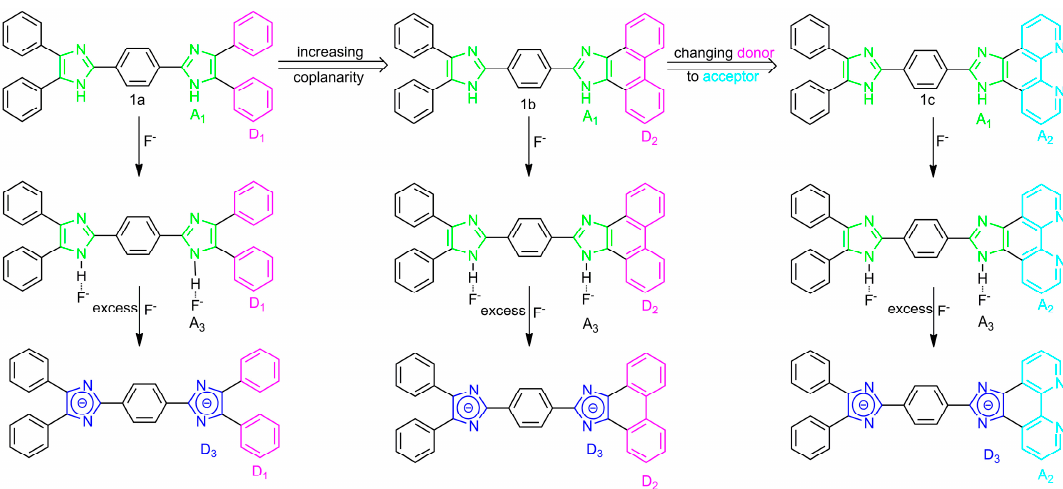
Scheme 2. Schematic diagram for electron transfer process of compounds 1a – 1c in the presence of Bu 4 N + F − (A = electron acceptor; D = electron